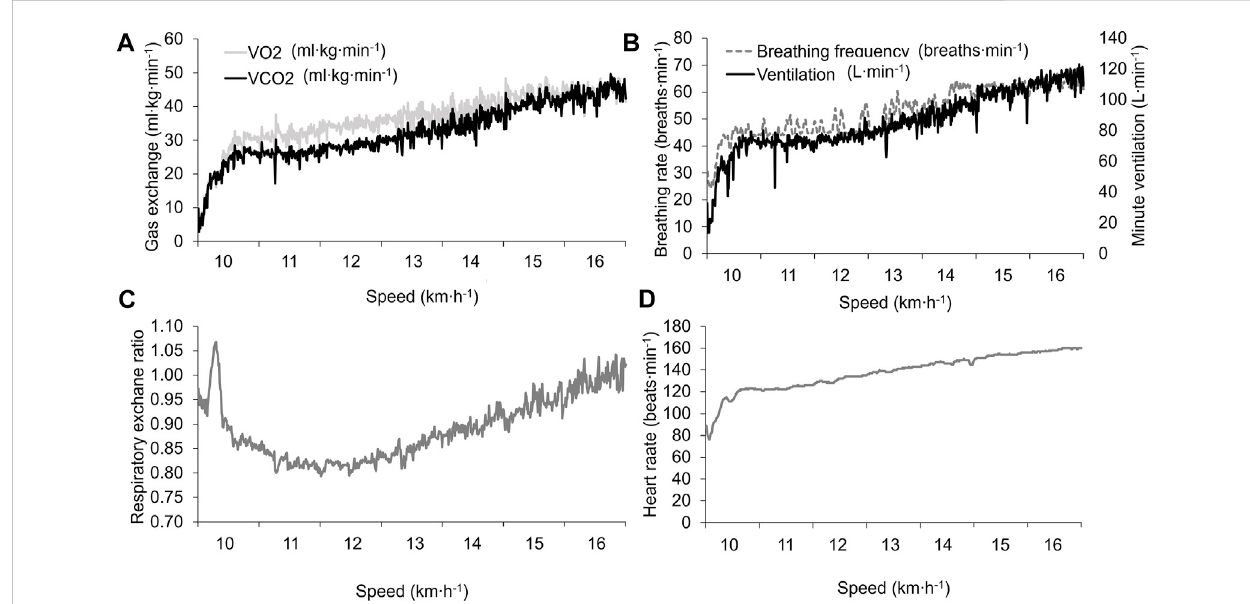
FIGURE 1 Physiological outcomes during the laboratory vV _ O 2 max assessment. (A) V _ O 2 and V _ CO 2 relative to body mass; (B) respiratory rate and minute ventilation; (C) respiratory exchange ratio; and (D) heart